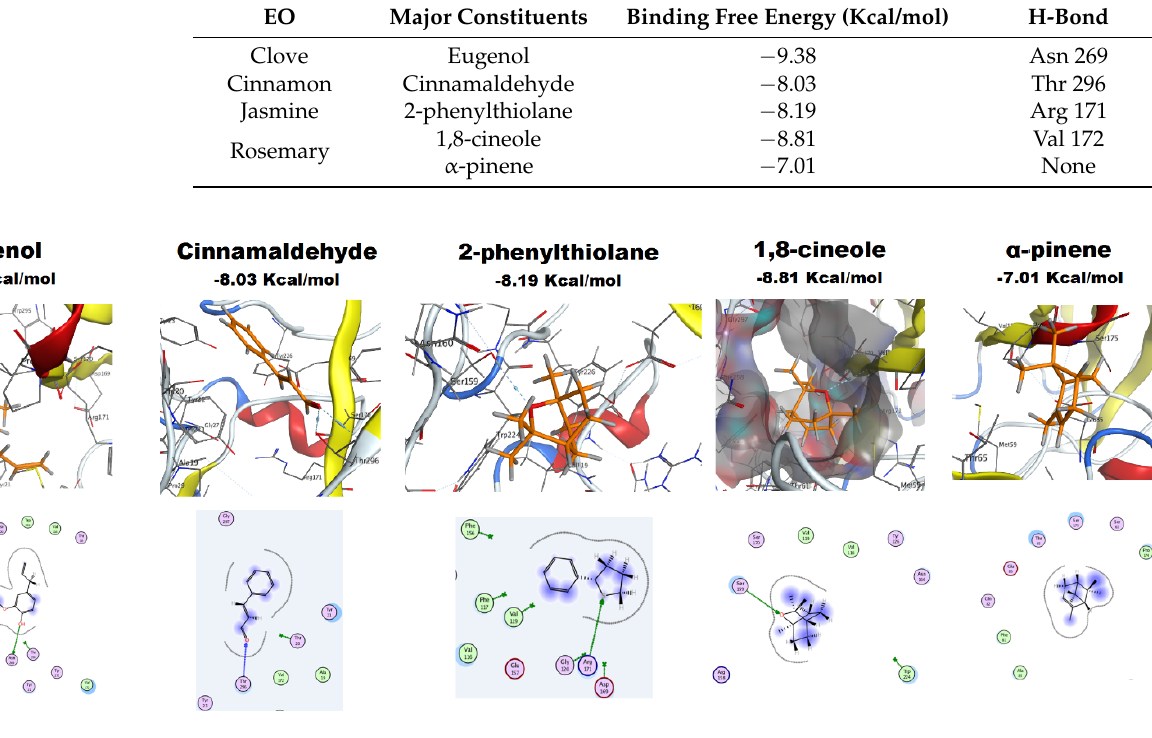
Figure 6. The putative binding mode (2D and 3D) with the mol-dock scores of Eugenol (clove oil); Cinnamaldehyde 2- Phenylthiolane and rosemary major constituents; 1,8-cineol; α -pinene into the pocket of the C. albicans Als3 surface protein.